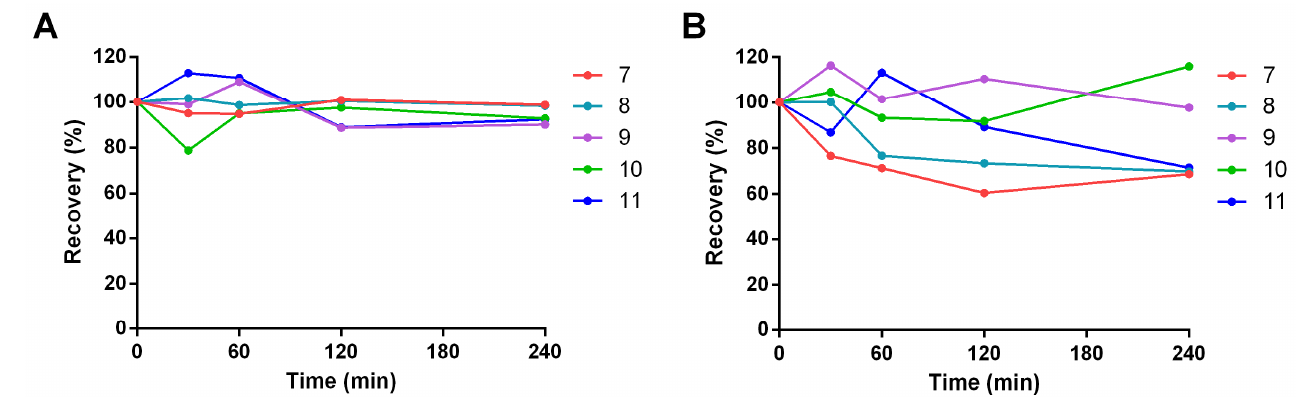
Figure 3. Chemical stability of compounds ( 7 – 11 ). ( A ) Chemical stability of compounds ( 7 – 11 ) at gastric pH (2.0). ( B ) Chemical stability of compounds ( 7 – 11 ) at plasma pH (7.4). Experiments